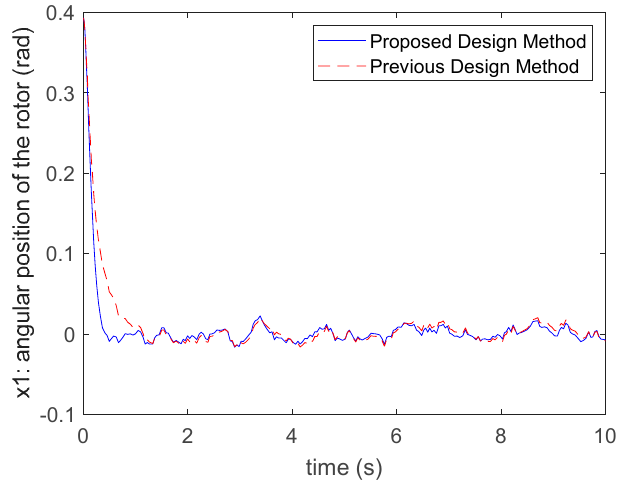
Figure 13. The comparison of state ( )